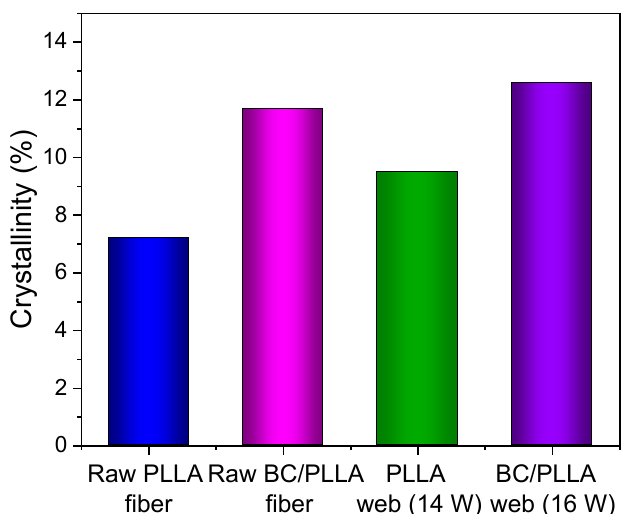
Figure 15. Crystallinities of raw PLLA and BC/PLLA fibers and electrospun PLLA (14 W) and BC/PLLA (16 W) webs calculated from total heat flow curves.